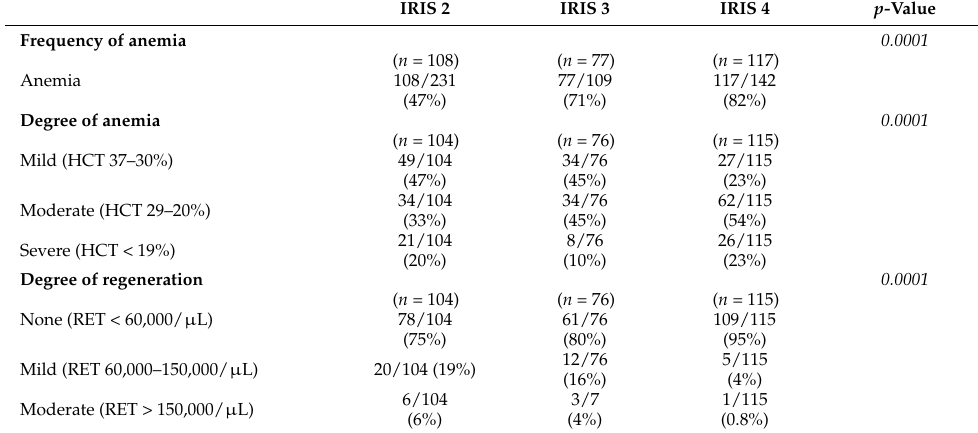
Table 2. Chi squared comparison of the frequency and degree of anemia and regeneration rate among dogs at different CKD IRIS